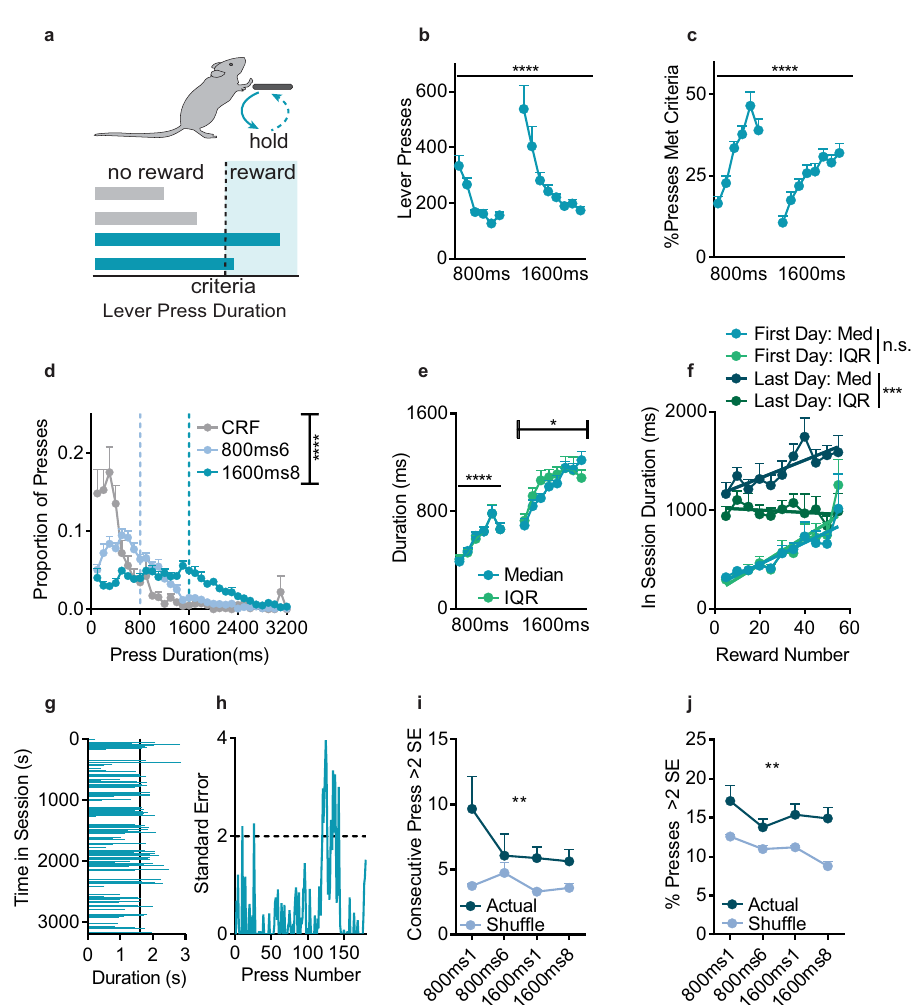
Fig. 1 Mice learned an unstructured, self-generated, self-paced lever press hold down task. a Behavioral schematic; mice learn to press and hold down a lever for at least a minimum duration to earn food reward. b Total Lever Presses across training days (1-way ANOVA, main effect of day, F 2.9, 31.9 = 12.0, p < 0.0001). c %Presses met criteria (1-way ANOVA, main effect of day F = 17.2, p < 0.0001). d Histogram of lever press durations (100 ms bins) 4.22, 46.5 on the fi nal pretraining day (CRF = Continuous Ratio of Reinforcement), and fi nal 800 ms and 1600 ms days. Dashed lines indicate criterion. 2-way RM ANOVA, main effect of Duration Bin F 31,1056 = 34.1, p < 0.0001, and an interaction (Duration Bin/Criterion) F 62,1056 = 10.5, p < 0.0001. e Median